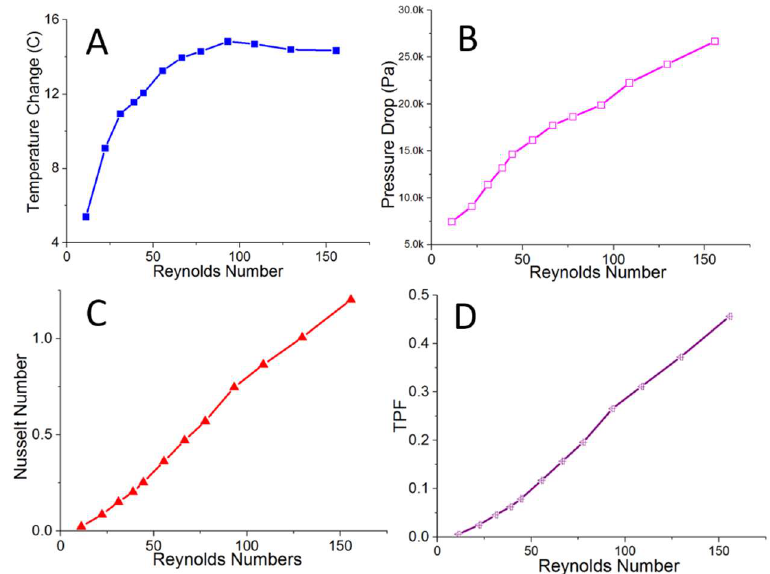
Figure 3. The experimental results of the single-channel rolled-up microfluidic system. The device was immersed into a warm water bath at constant temperature of 50 ◦ C, as illustrated in Figure 2A. The flow rates of DI water in the microchannel were varied to determine the thermal performance of this device. ( A ) The temperature change of water was plotted against the Reynold number. ( B ) The pressure drop along the channel was measured at varied flow rates. The thermal performances of the rolled-up device, determined via Nusselt number (Nu) and thermal performance factor (TPF) ( C , D ), respectively. In this thermal test, the fluidic flow rates were varied from 0.5 to 7 mL/min, corresponding to Re of 10 to 160.